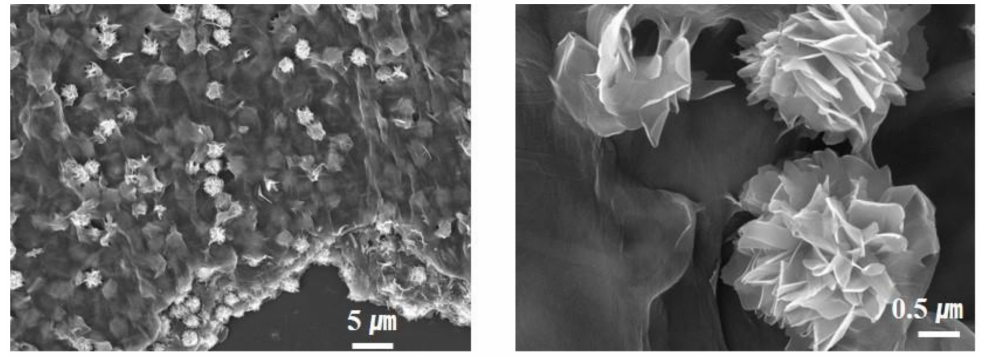
Figure 5. SEM images of the RGO/F-SnS NCs synthesized in this